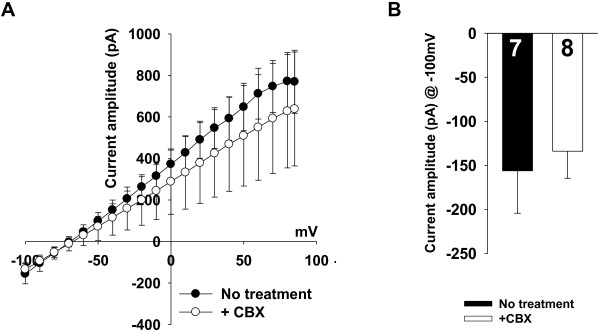
TFLLR-induced conductance is independent on activation of gap-junction hemichannels and Ca2+ activated potassium channel. A. Averaged current–voltage relationships from TFLLR-induced current using Cs-Glutamate pipette solution in the presence of gap junction blocker (+CBX) or normal ACSF bath solution (No treatment). B. Bar graphs indicates the averaged current amplitude at holding potential of -100 mV (Current amplitude @ -100 mV) to test whether glutamate-mediated current in astrocytes is reduced by inhibiting the gap junction activity. p = 0.7 for Current amplitude @ -100 mV; unpaired t-test.